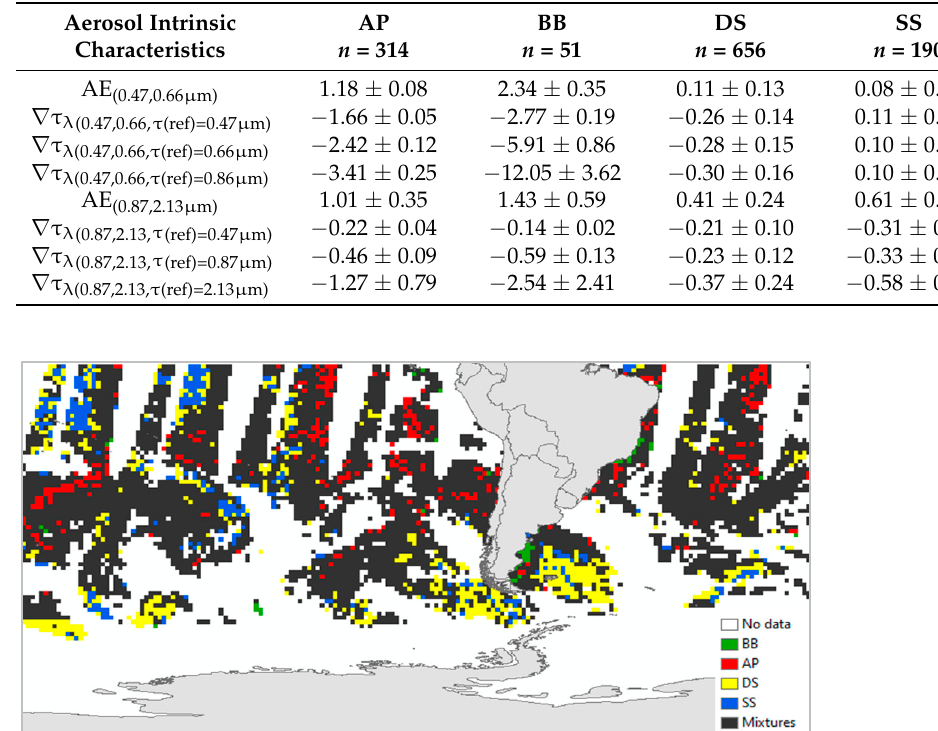
Figure 6 . Distribution of aerosol types: anthropogenic pollutant (AP), biomass burning (BB), dust (DS), sea salt (SS), and mixtures based on their spectral derivatives calculated from MODIS daily aerosol products (MOD08_D3).